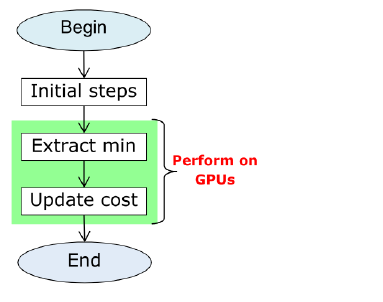
Figure 7. The flo chart of parallel Dijkstra algorithm for searchingBT-Graph